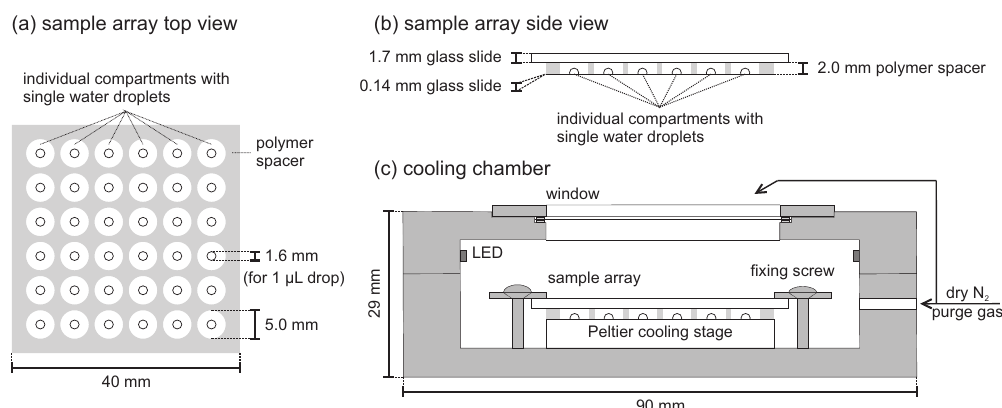
Figure 1. Schematic of the Bielefeld Ice Nucleation ARraY (BINARY) setup. (a) Top view of the 6 × 6 droplet array. The droplets are separated from each other by a polymer spacer creating individual compartments. (b) Side view showing the sealing of the compartments by top and bottom glass slides. (c) Position of the sample array on the Peltier cooling stage inside the cooling chamber.